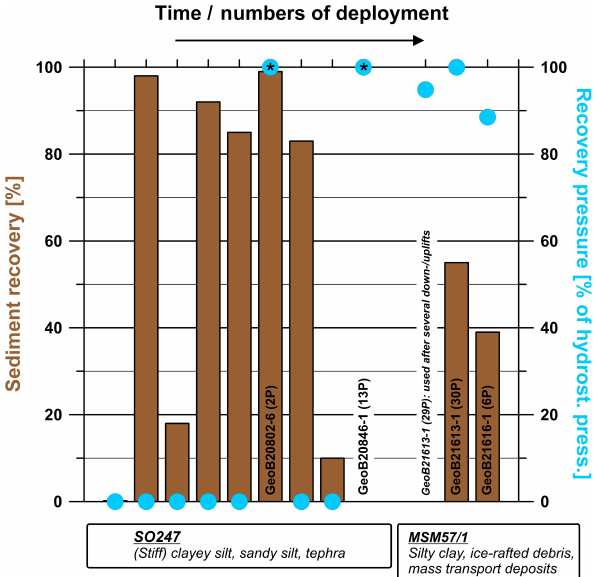
Figure 2. Overview of sediment recovery rates (in percentage of liner volume) and recovery pressure (in percentage of hydrostatic pressure at the drill site) obtained in the course of MDP deploy- ments and modifications during cruises SO247 and MSM57/1. ∗ = Pressure inside pressure vessel higher than hydrostatic pressure due to initial overcharge by the pressure accumulator. Specifications of drill sites are provided in Table A1 in the